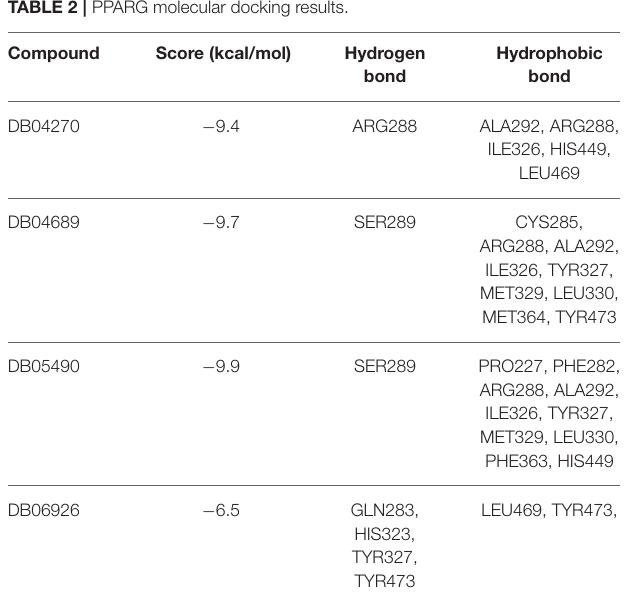
TABLE 2 | PPARG molecular docking